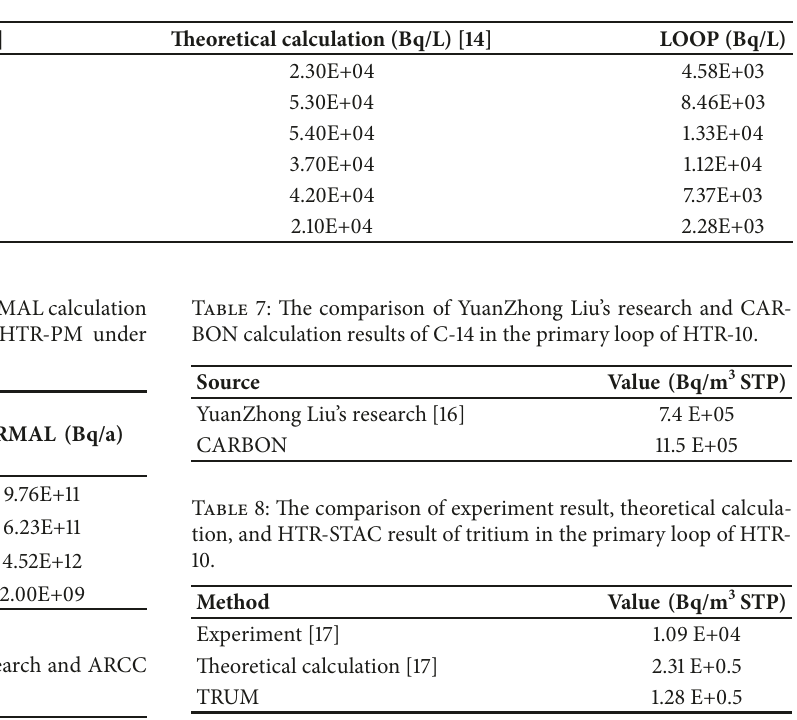
Table 4: The comparison of experiment result, theoretical calculation, and HTR-STAC result of several typical nuclides in primary circle coolant of HTR-10.